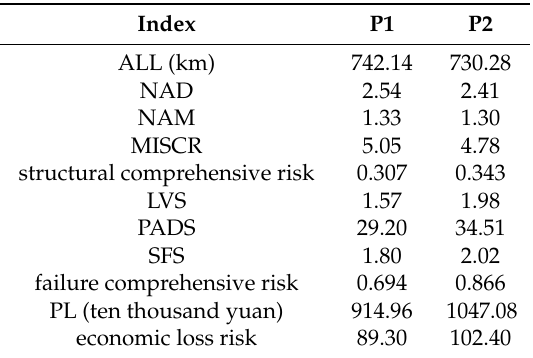
Table 3. System risk after chain failure.